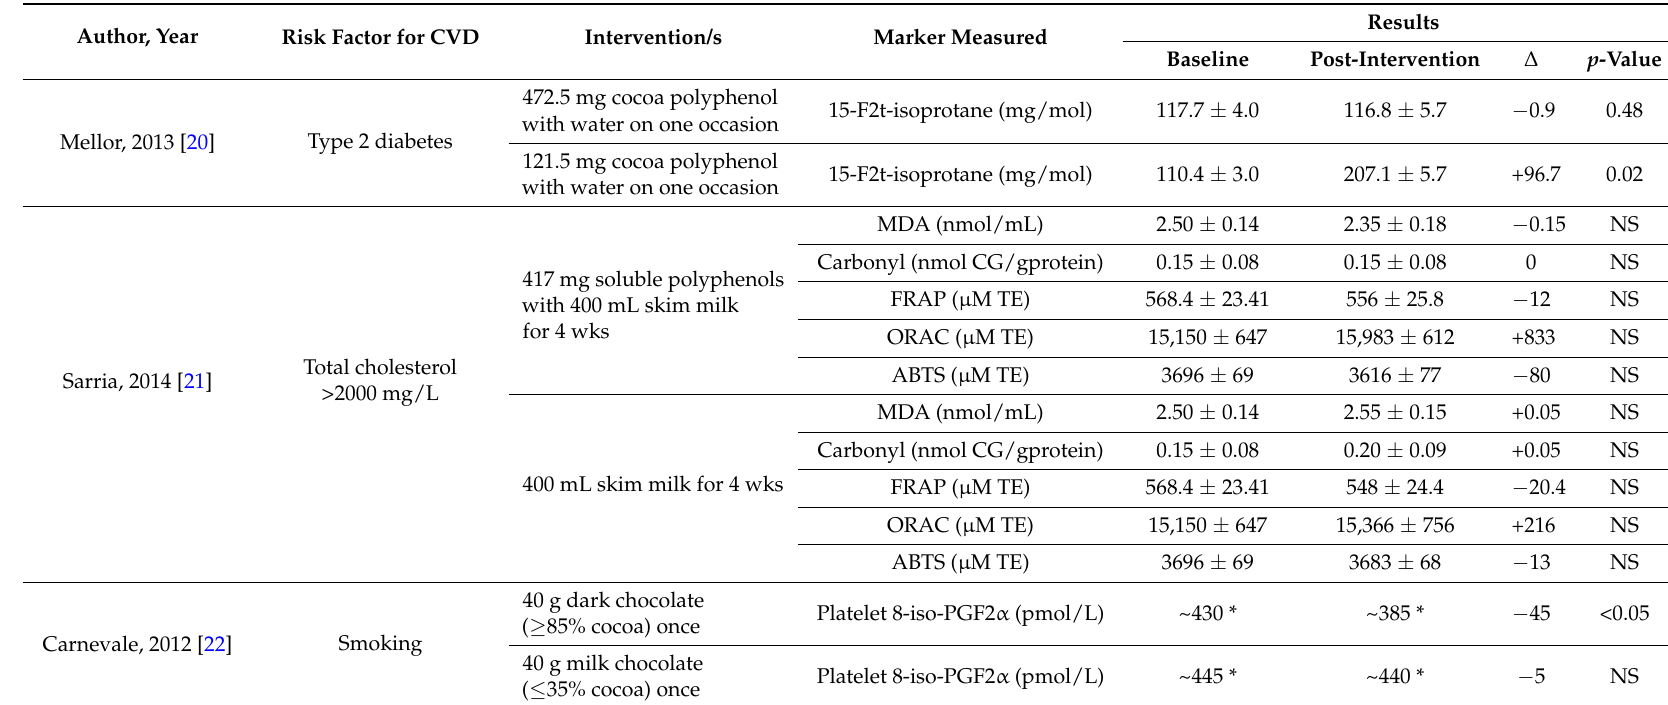
Table 3. Effect of cocoa polyphenols on oxidative stress markers at baseline and